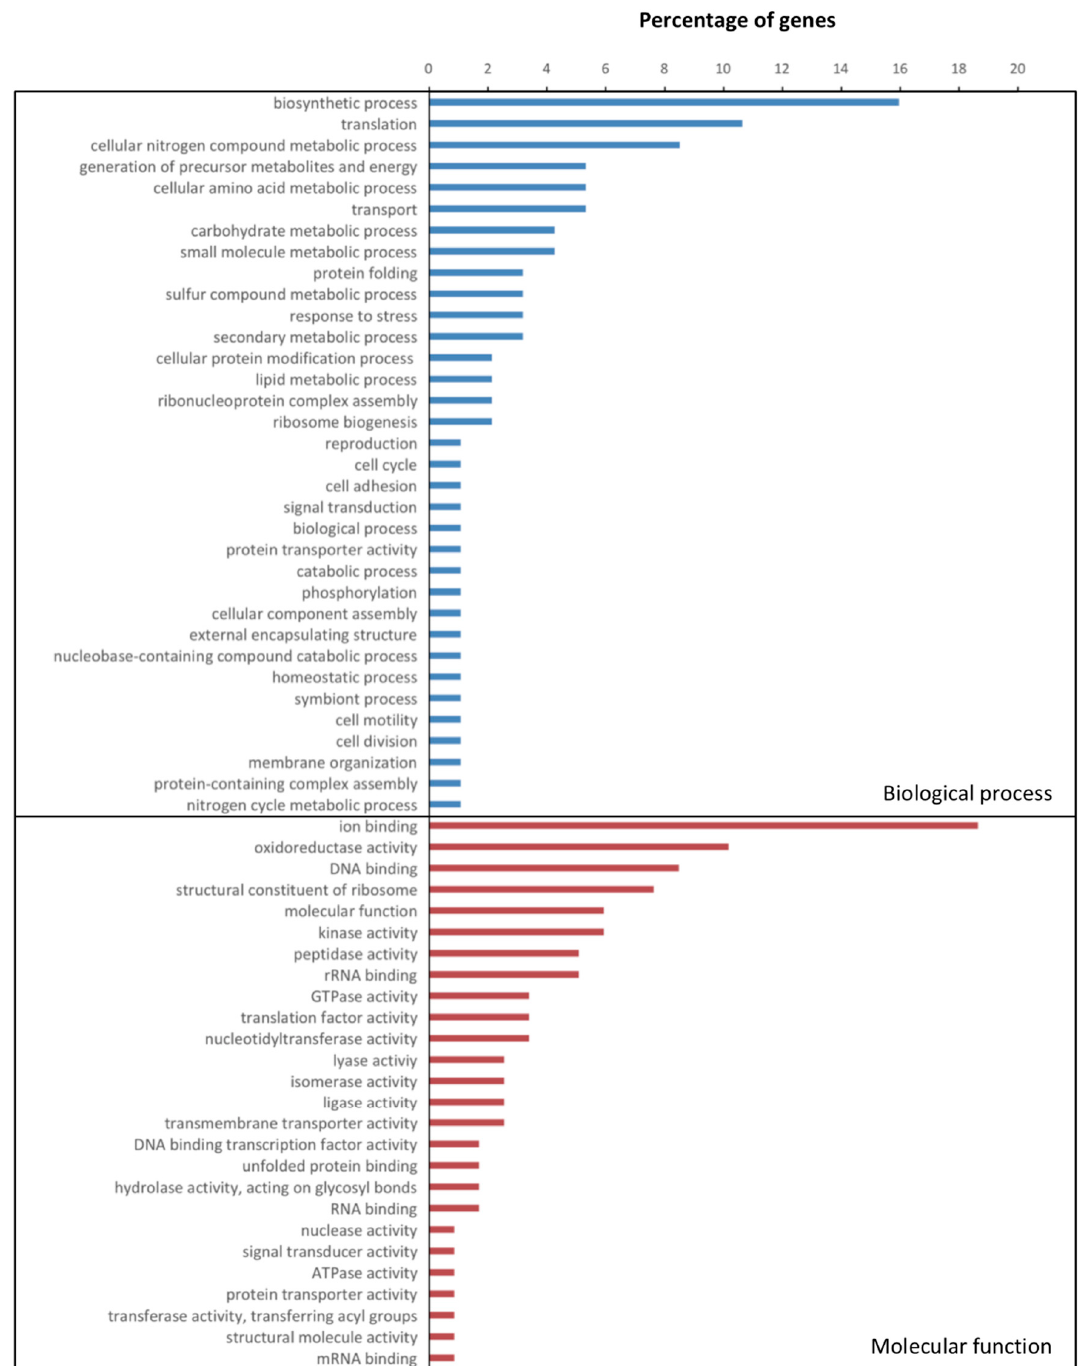
Figure 3. Gene ontology (GO) categories less expressed at 29 days post inoculation (dpi) in Xanthomonas fragariae . Two classes of GO terms, namely biological process and molecular functions in inoculated strawberry plants between 12 and 29 dpi, are shown as a percentage of present genes.